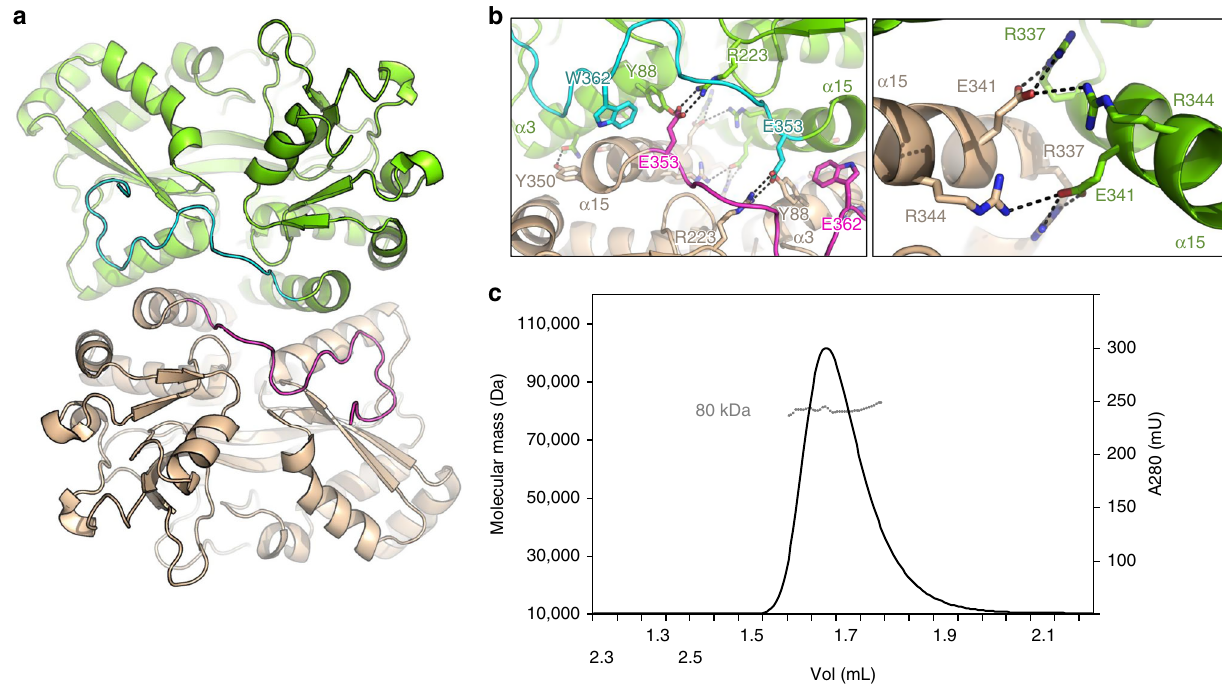
Fig. 4 IbpS is a dimer. a Cartoon representation of the IbpS dimer between chains A (green) and D ’ (wheat). The C-terminal tails of chains A and D ’ are colored blue and magenta, respectively. b Close-up views of the dimer interface. The residues involved are indicated, and the side chains are shown as ball- and-sticks and colored like that in a . c SEC-MALS analysis of the IbpS dimer solved at a resolution of 1.8 Å (Table 1). The protein crystalized in a different crystal form with the P1 space group and four mole- cules per asymmetric unit. All four molecules were bound to a single-iron atom at the same binding site (Fig. 5a – c). The structures of IbpS and Fe-IbpS were nearly identical and no important structural modi fi cation was observed. As suspected from our previous analysis, the metal did not bind at the cano- nical SBP cluster D protein substrate-binding pocket. Instead, the iron atom was located near the dimer interface (Fig. 5a), at the entry of tunnel identi fi ed previously (Supplementary Fig. 9). The metal sits in a cavity formed by residues S86, K87, Q110, T111, NATURE COMMUNICATIONS| (2019) 10:4853